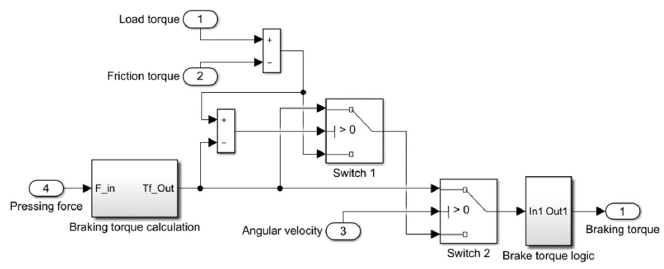
Figure 6. Contact force calculation sub ‐ module.